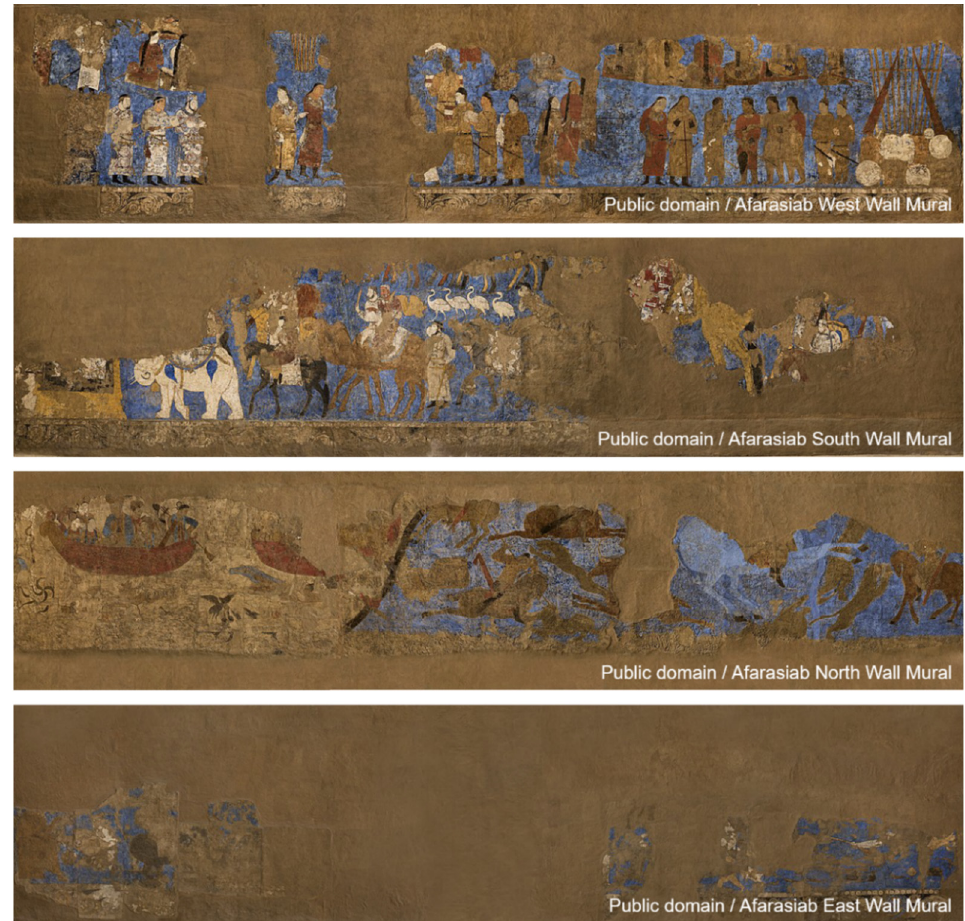
Figure 1. Afrasiab murals (the present photographs are Public Domain image of the UNESCO [1]).